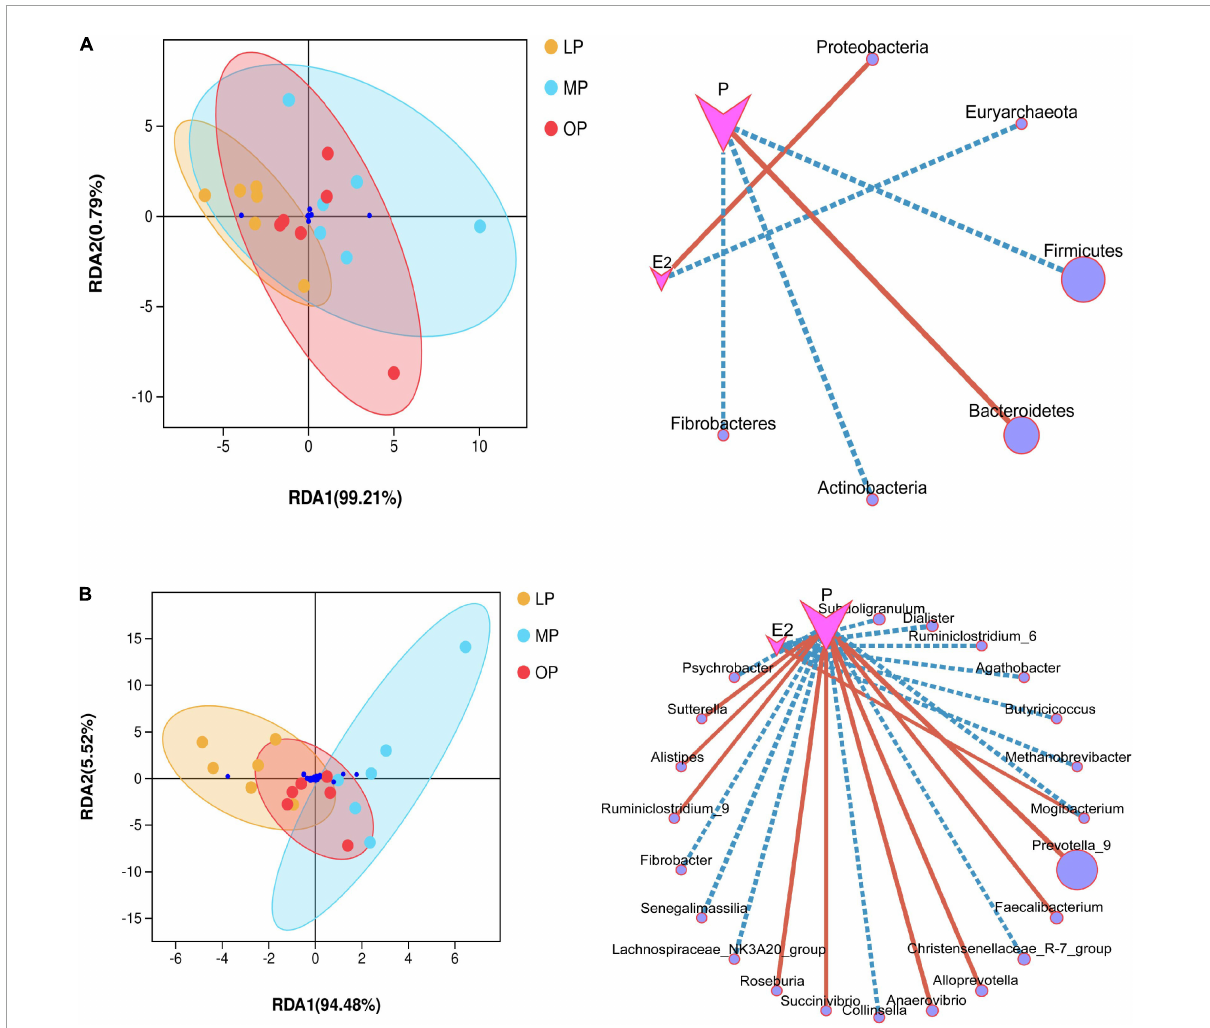
FIGURE4 Environmental factor analysis. Redundancy analysis (RDA) and correlation network diagram at the phylum (A) and genus (B)